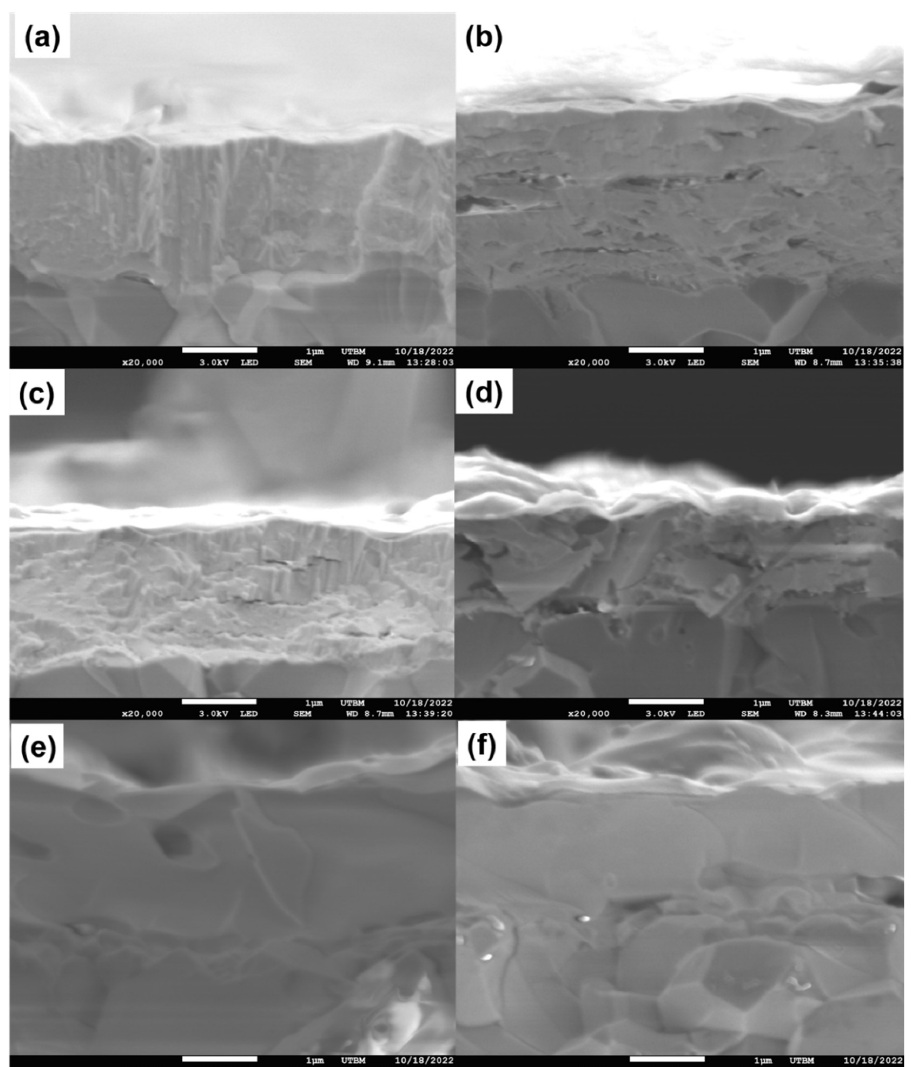
Figure 8. FESEM characterizes of the brittle fracture cross-section of the Bi 1.5 Y 0.5 O 3 films deposited on alumina plate varies with the different annealing temperature of ( a ) as deposited, ( b ) 400 °C, ( c )